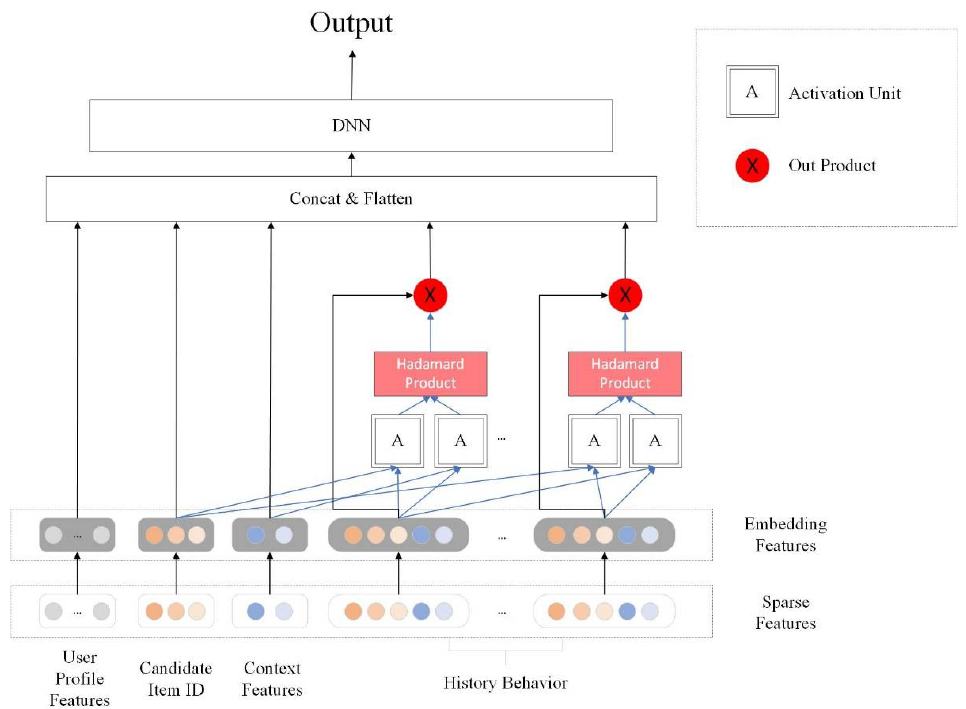
Figure 1. Framework of DICN model. The black line in the figure represents the embedding vector fed into the Concat and Flatten functions and the outer product; the blue line represents the embedding vector fed into the local activation unit and the Hadamard product.